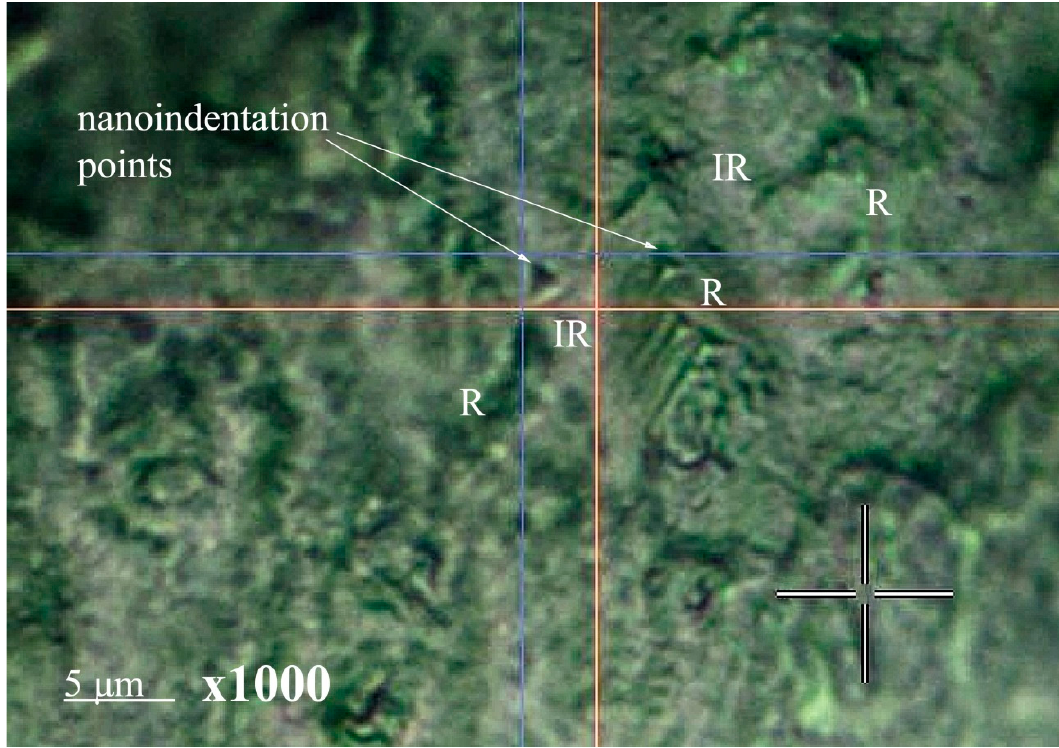
Figure 12. Typical image of the surface area of mineralized dental tissue, showing the enamel rods and inter-rods areas, as well as the nanoindenter prism imprint. R: the enamel rods areas; IR: the enamel inter-rods areas.